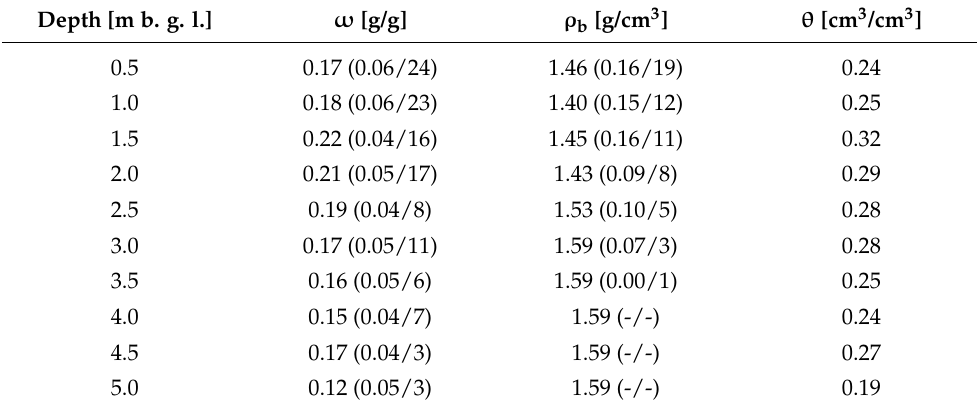
Table 5. Average bulk densities ( ρ b ) and gravimetric water contents ( ω ), which were determined in the unsaturated zone, and with Equation (1) calculated average volumetric water contents ( θ ). The standard deviation and the number of measured values used in each case are also shown in the brackets. For the depths 4.0 m to 5.0 m b. g. l., the average ρ b calculated for 3.5 m b. g. l. is also assumed in a simplified